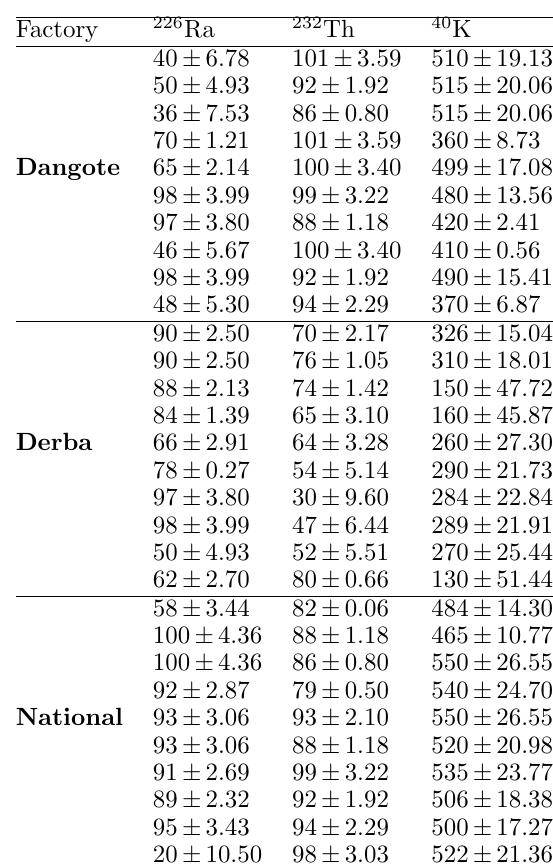
Table 1. The radioactivity concentrations of natural radionuclides in cement samples in Bq kg − 1